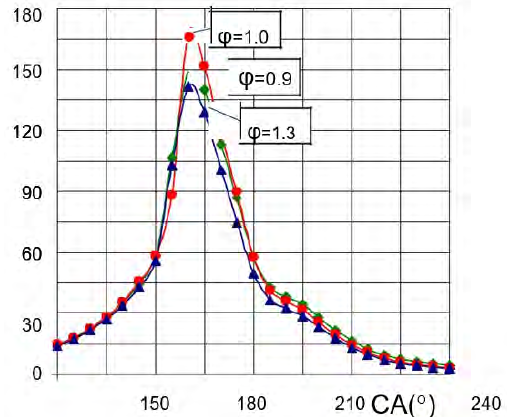
Figure 9. Variation of XO2 ε /k in function of crank angle with different equivalence ratio (D20, n=2100rpm)